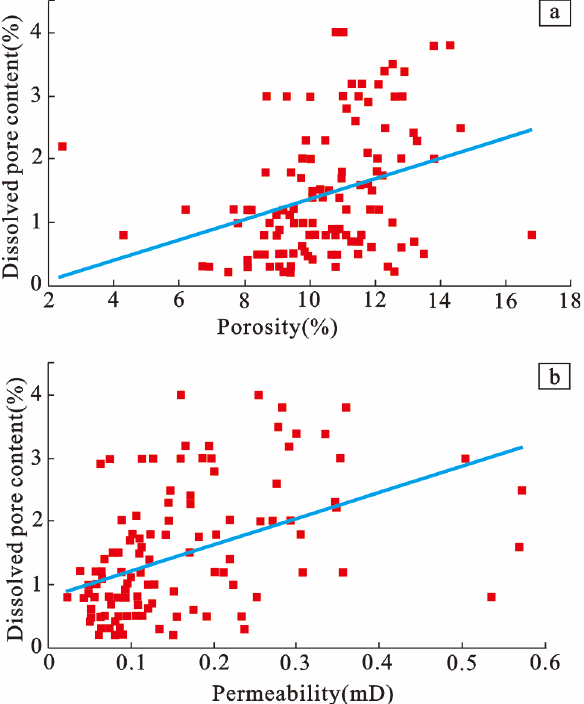
Figure 13. Cross-plots showing the relationship between dissolved pore content and ( a ) porosity and ( b )